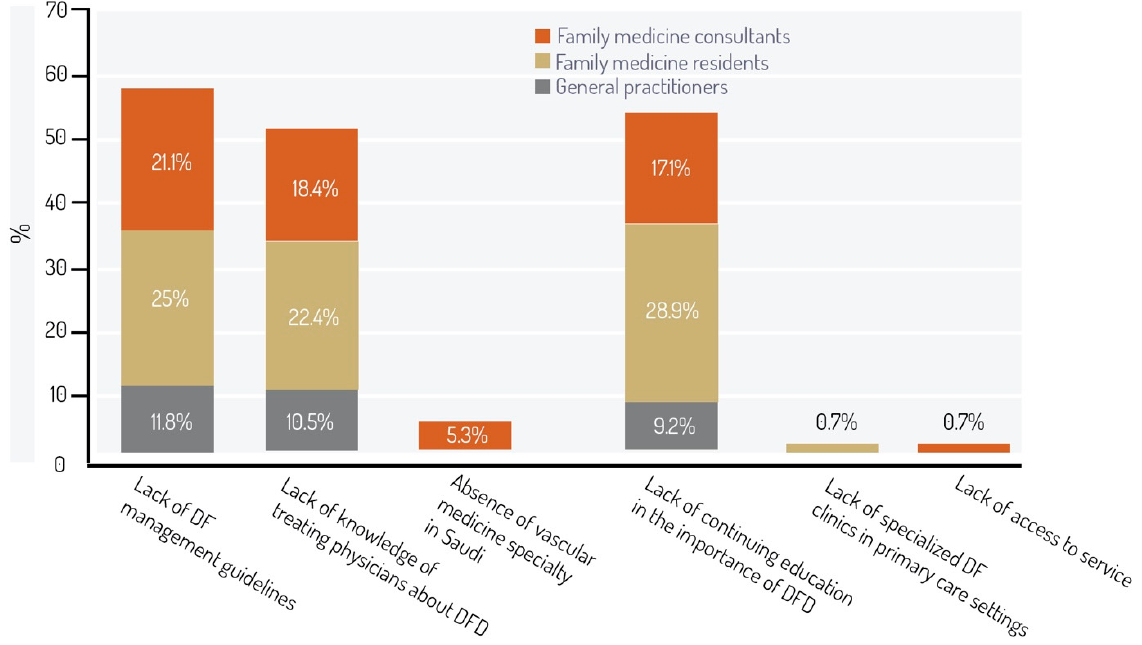
Figure 1. Barriers toward optimal care for diabetic foot patients. DF, diabetic foot; DFD, diabetic foot disease.